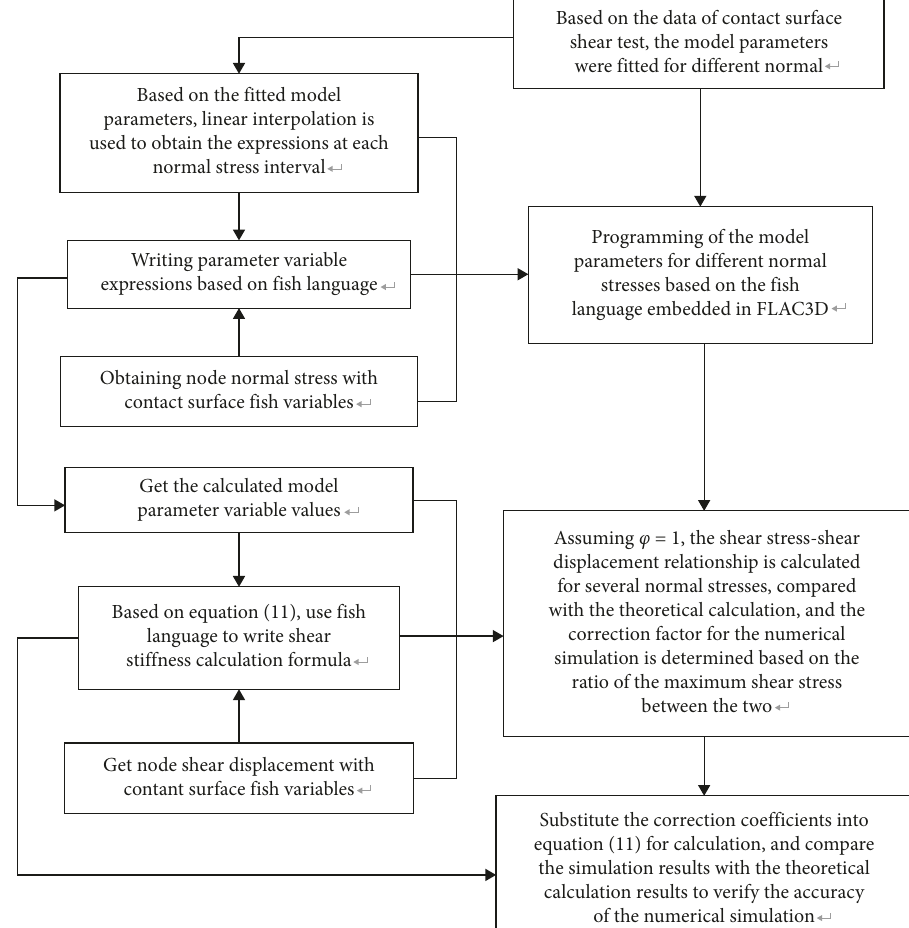
Figure 8: Flowchart of FLAC3D model implementation.